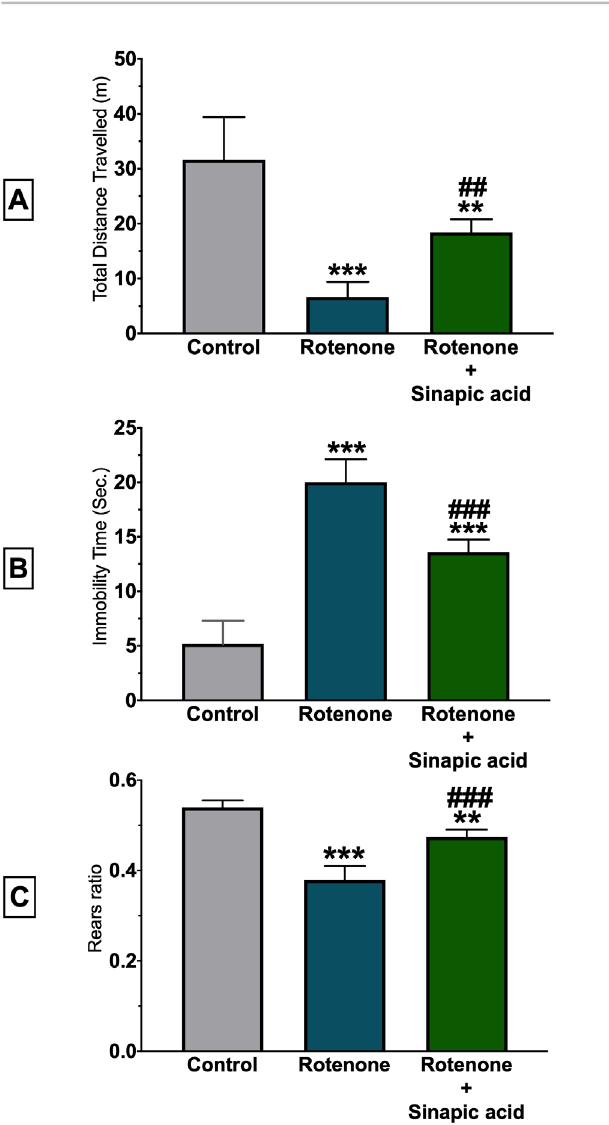
FIGURE 2 - Decreased traveled distance (A), increased immobility time (B), and impaired rears ratio (C) due to the rotenone insult were significantly alleviated by sinapic acid (n=8 for each group). All data expressed as mean ± SD. ***p<0.001, **p<0.01 versus control group, ###p<0.001, ##p<0.01 versus rotenone group.